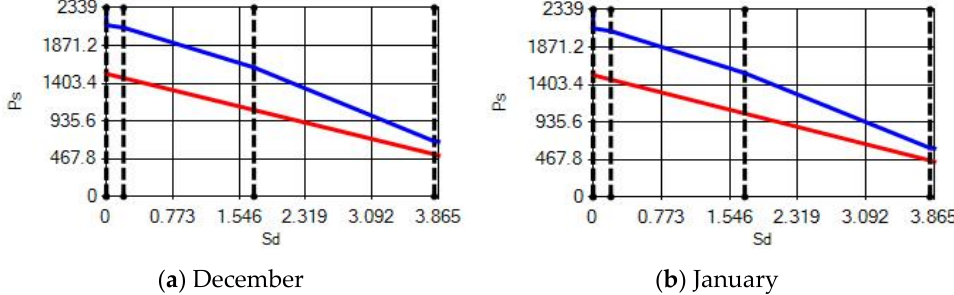
Figure 23. Condensation and evaporation amount chart for the building elements of the pumice external wall for the 2nd zone for ( a ) December and ( b ) January.